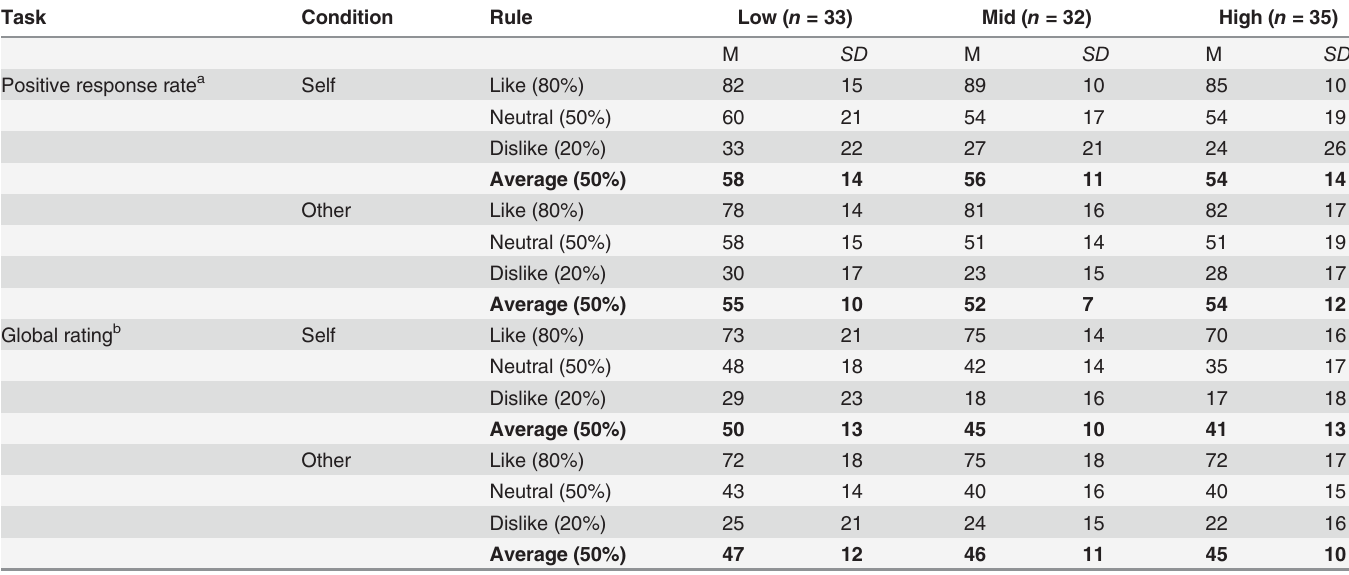
a ( n positive responses/32) *